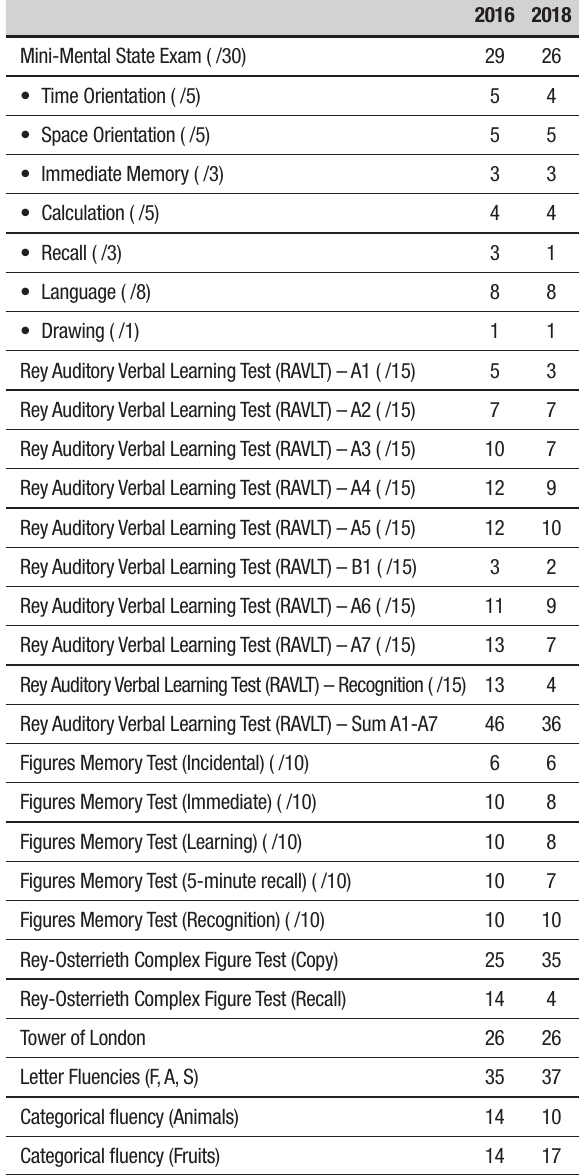
Table 1. Cognitive